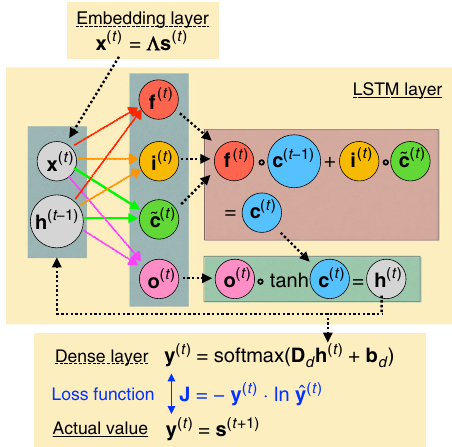
Fig. 1 Neural network schematic. The schematic plot of the simple character-level language model used in this work. The model consists of three main parts: The embedding layer, the LSTM layer, and a dense output layer. The embedding layer is a linear layer which multiplies the one-hot input s ( t ) by a matrix and produces an embedding vector x ( t ) . The x ( t ) is then used as the input of LSTM network, in which the forget gate f ( t ) , the input gate i ( t ) , the output gate o ( t ) , and the candidate value ~ c ð t Þ are all controlled by ( x ( t ) , h ( t − 1) ). The forget gate and input gate are then used to produce the update equation of cell state c ( t ) . The output gate decides how much information propagates to the next time step. The output layer predicts the probabilities ^ y ð t Þ by parametrizing the transformation from h ( t ) to ^ y with learned weights D d and learned biases b d . Finally, we can compute the cross entropy between the predicted probability distribution ^ y ð t Þ and the true probability distribution y ( t ) = s ( t + 1)